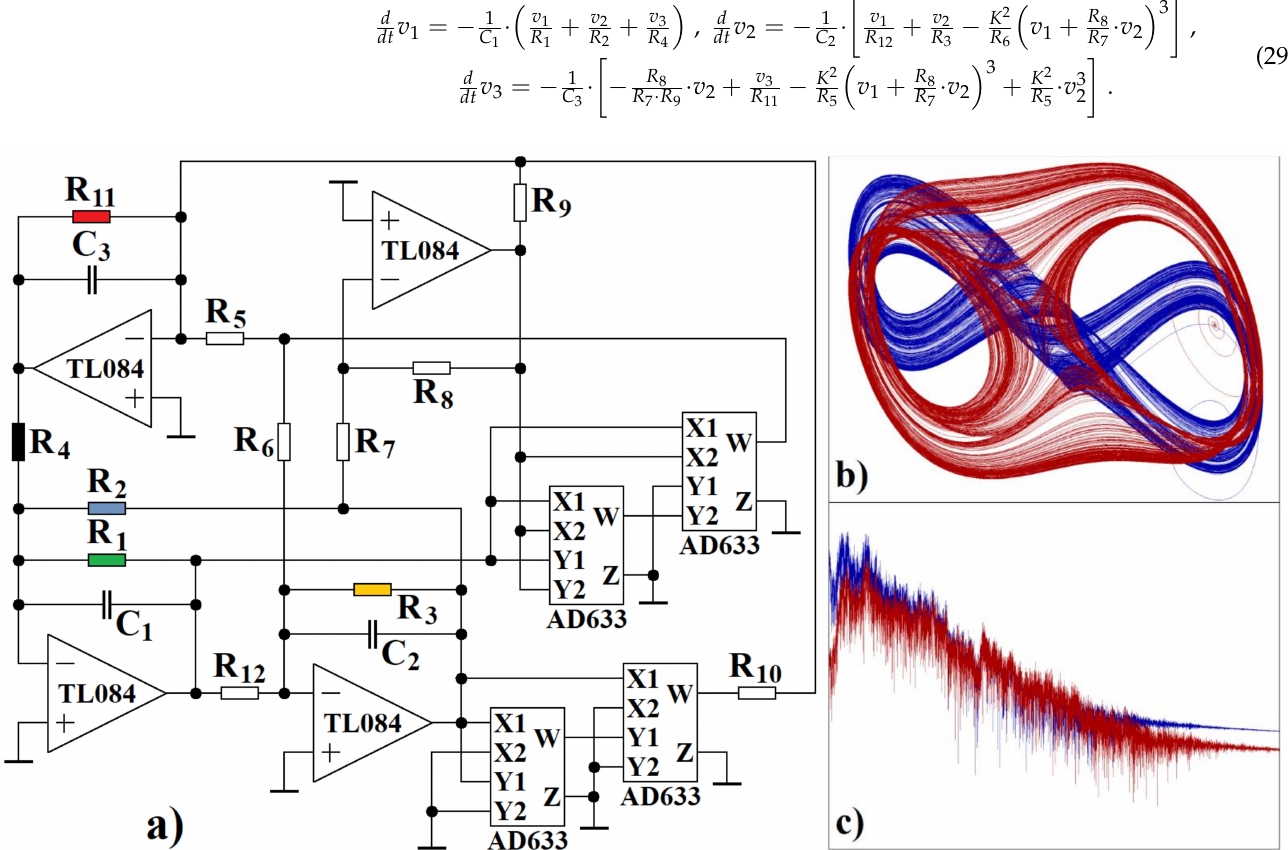
Figure 15. Darlington’s stage with resistive load: ( a ) analog computer-based circuit realization, ( b ) plane projection v 1 vs. v 2 (blue color) and v 1 vs. v 3 (red color), ( c ) frequency spectrum of chaotic signal v 1 (blue color) and v 3 (red